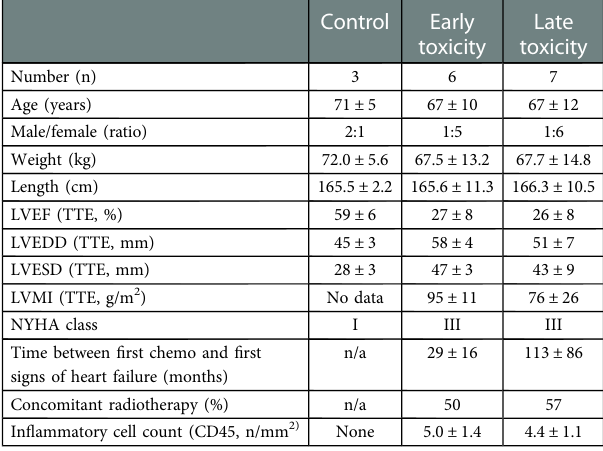
TABLE 1 Endomyocardial biopsies for deep RNA sequencing: patient